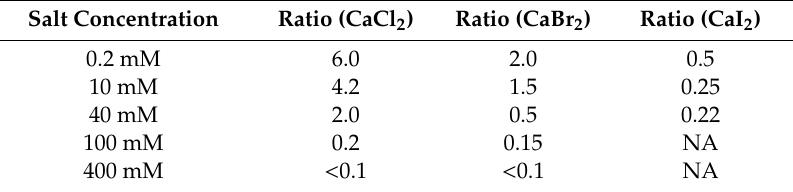
Table 1. Molar ratio of dimer/monomer of gramicidin A in the presence of CaCl 2 , CaBr 2 and CaI 2 at various concentrations.